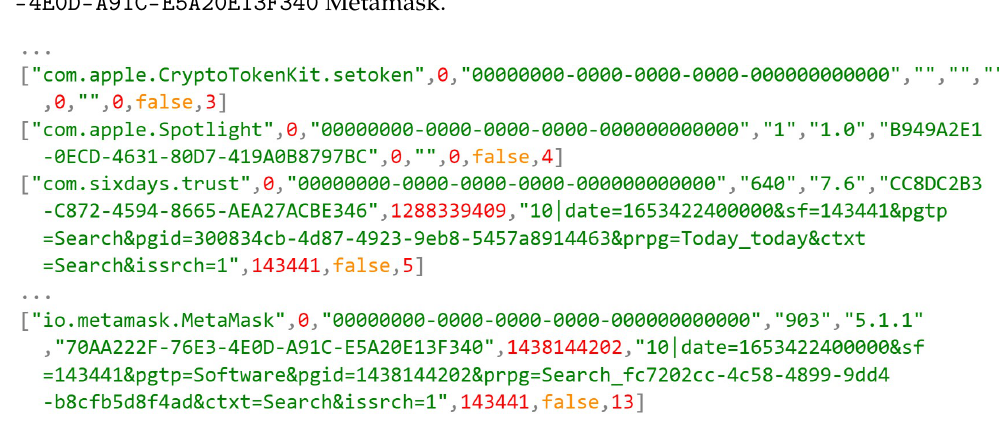
Figure 8. The identifier called DeviceUID for both apps within session_bundles.log file.